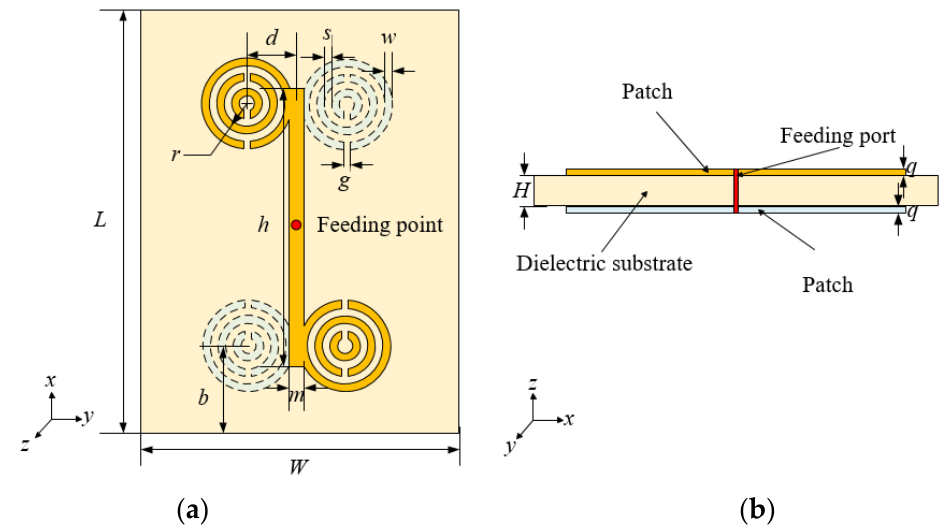
Figure 3. Proposed array antenna with ( a ) the top view; ( b ) the side view.